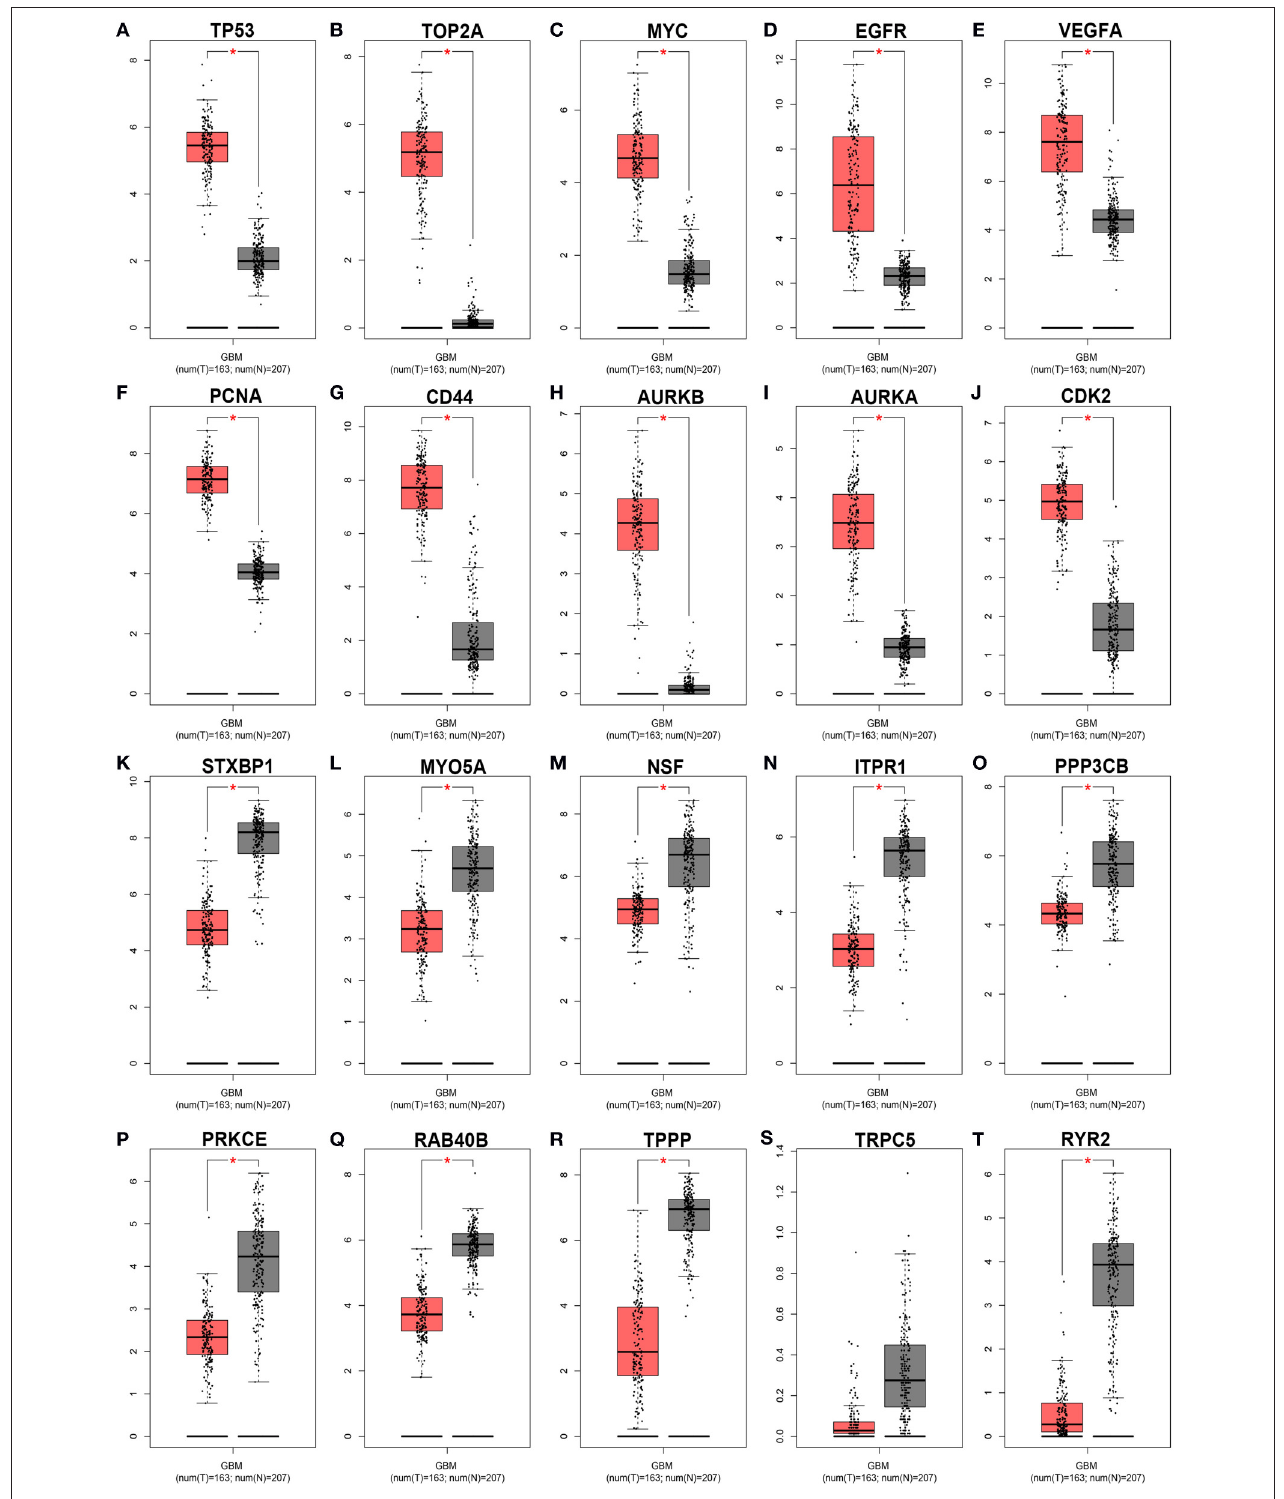
FIGURE 9 | The expression levels of 20 hub genes from the GEPIA database. * P < 0.05.